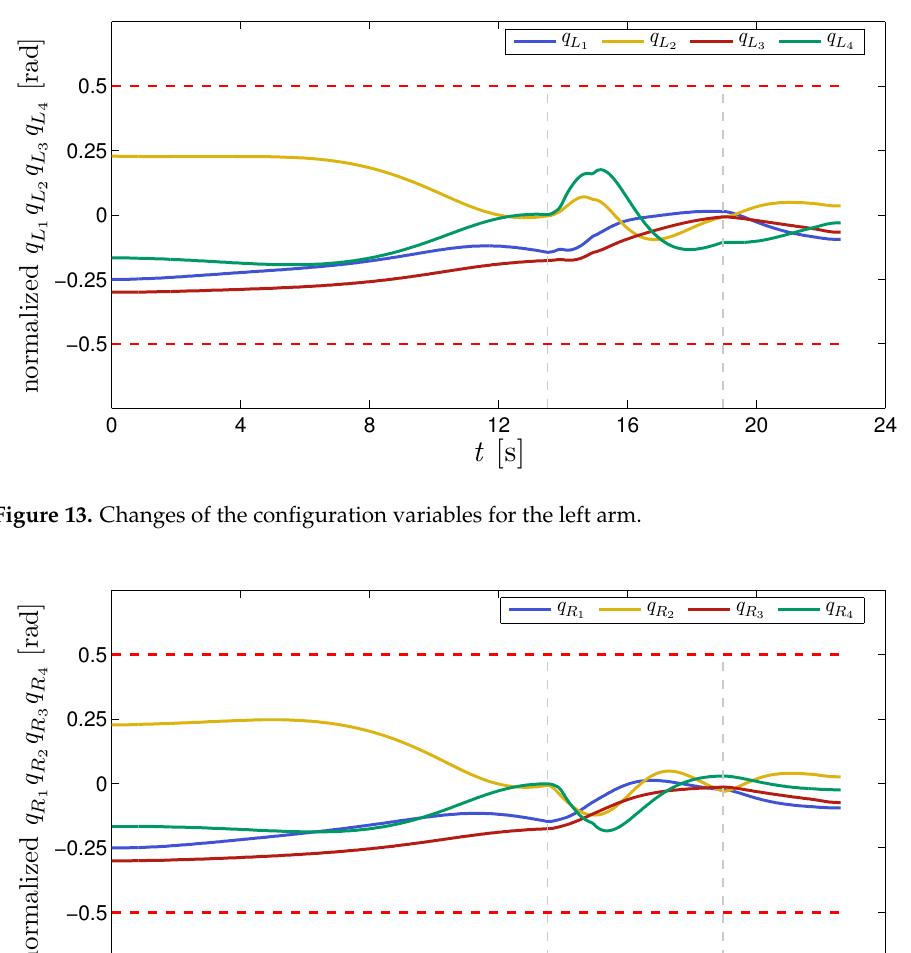
Figure 14. Changes of configuration variables for the right arm.